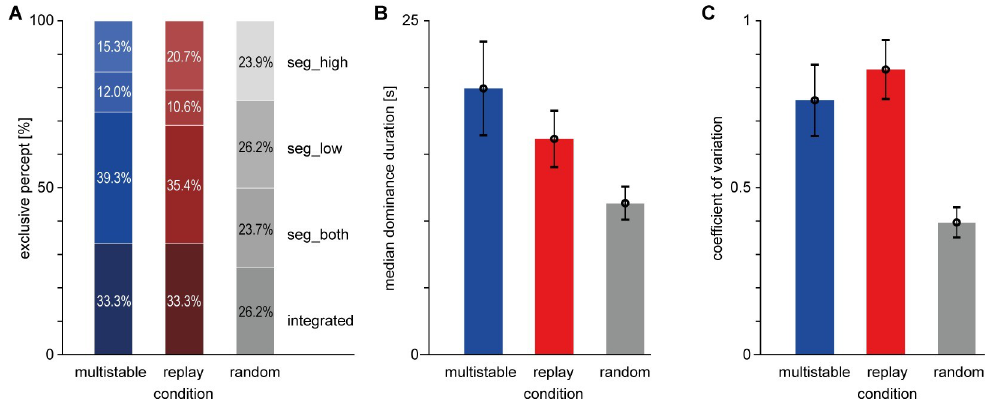
Fig 6. Behavioral data, Study 2. A ) Percentages of exclusive integrated percept (bottom), exclusive segregated percept with both tones in the foreground (2nd from bottom), exclusive segregated percept with low tone in the foreground (2nd from top), exclusive segregated percept with high tone in the foreground (top). In the random condition, button assignments are arbitrary. B ) Median dominance duration per participant and condition, mean and standard error of the mean (sem) across listeners. C ) Coefficient of variation per listener; error bars depict mean and sem across listeners. seg_both, 12.0% for seg_low, and 15.3% for seg_high. In the replay condition, the percentages of identified segments should be similar to those of the multistable condition, which is the case as in Study 1, with 33.3% for the integrated, 35.4% for seg_both, 10.6% for seg_low, and 20.7% for seg_high. In the random condition, participants again produced approximately equal pressing times for each button (26.2%, 23.7%, 26.2% and 23.9%). Median dominance durations collapsed across all response types are shown in Fig 6B. As in Study 1, median dominance durations were slightly longer in the multistable condition ( M = 19.93 s, SD = 15.30 s) than in the replay condition ( M = 16.16 s, SD = 9.20 s). They were again shorter in the random condition ( M = 11.34 s, SD = 5.37 s), but the difference was not as extreme as in Study 1, where median dominance durations in the random condition were almost four times lower ( M = 2.94 s) than in Study 2. Nevertheless, a significant difference between conditions was confirmed in the ANOVA on median dominance durations observed in Study 2 ( F (2,36) = 5.54, p = .008). Follow-up pair-wise comparisons showed differences between the multistable and random conditions ( t (18) = 2.60, p = .018) as well as between the replay and random conditions ( t (18) = 2.39, p = .028), both of which fall slightly above the Bonferroni-corrected alpha level. No significant difference between the median dominance durations in the multistable and replay conditions was observed ( t (18) = 1.67, p = .112). The exclusive button-press durations showed a mean coefficient of variation (CV) of 0.76 ( SD = 0.47) in the multistable, 0.85 ( SD = 0.39) in the replay and 0.40 ( SD = 0.20) in the ran- dom condition. Randomness of the button-press patterns as quantified by CV was thus again notably lower in the random condition, which was confirmed by a significant main effect of Condition in the ANOVA ( F (2,36) = 14.12, p < .001) and by follow-up pair-wise comparisons showing significant differences between the multistable and random conditions ( t (18) = 3.45, p = .003) as well as between the replay and random conditions ( t (18) = 5.48, p < .001), but not between the multistable and replay conditions ( t (18) = 1.12, p = .276). It should be noted that the low CV in the random condition of Study 2 does not indicate a violation of instructions because–unlike for Study 1 –the instructions did not ask participants to refrain from any rhythm in the timing of presses and releases. Importantly, the median interval between any two consecutive button presses in the random condition was now in a range that made the analysis of pupil effects feasible.